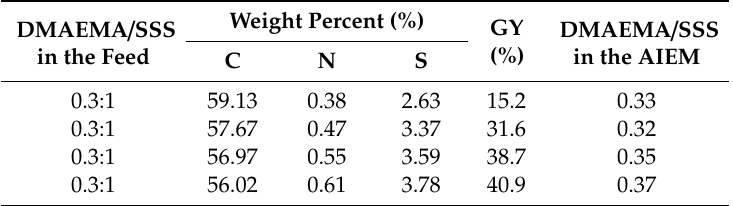
Table 1. The element analysis of the AIEM with different GY.